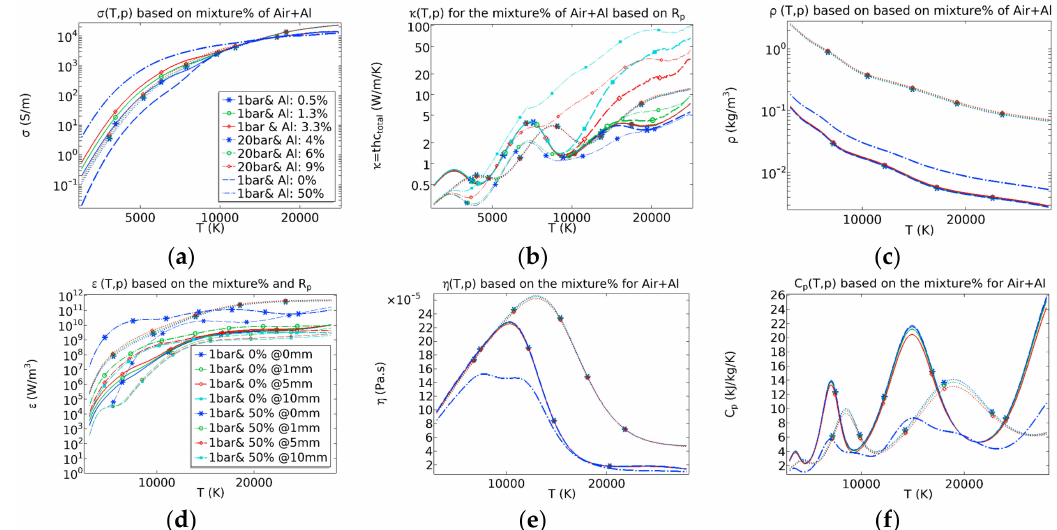
Figure 3. ( a ) Electrical conductivity, ( b ) Heat conductivity, ( c ) Mass density, ( d ) NEC, ( e ) Viscosity, and ( f ) Heat capacity of pure air and air-Al mixture at 1 and 20 bar at di ff erent mixture ratios.